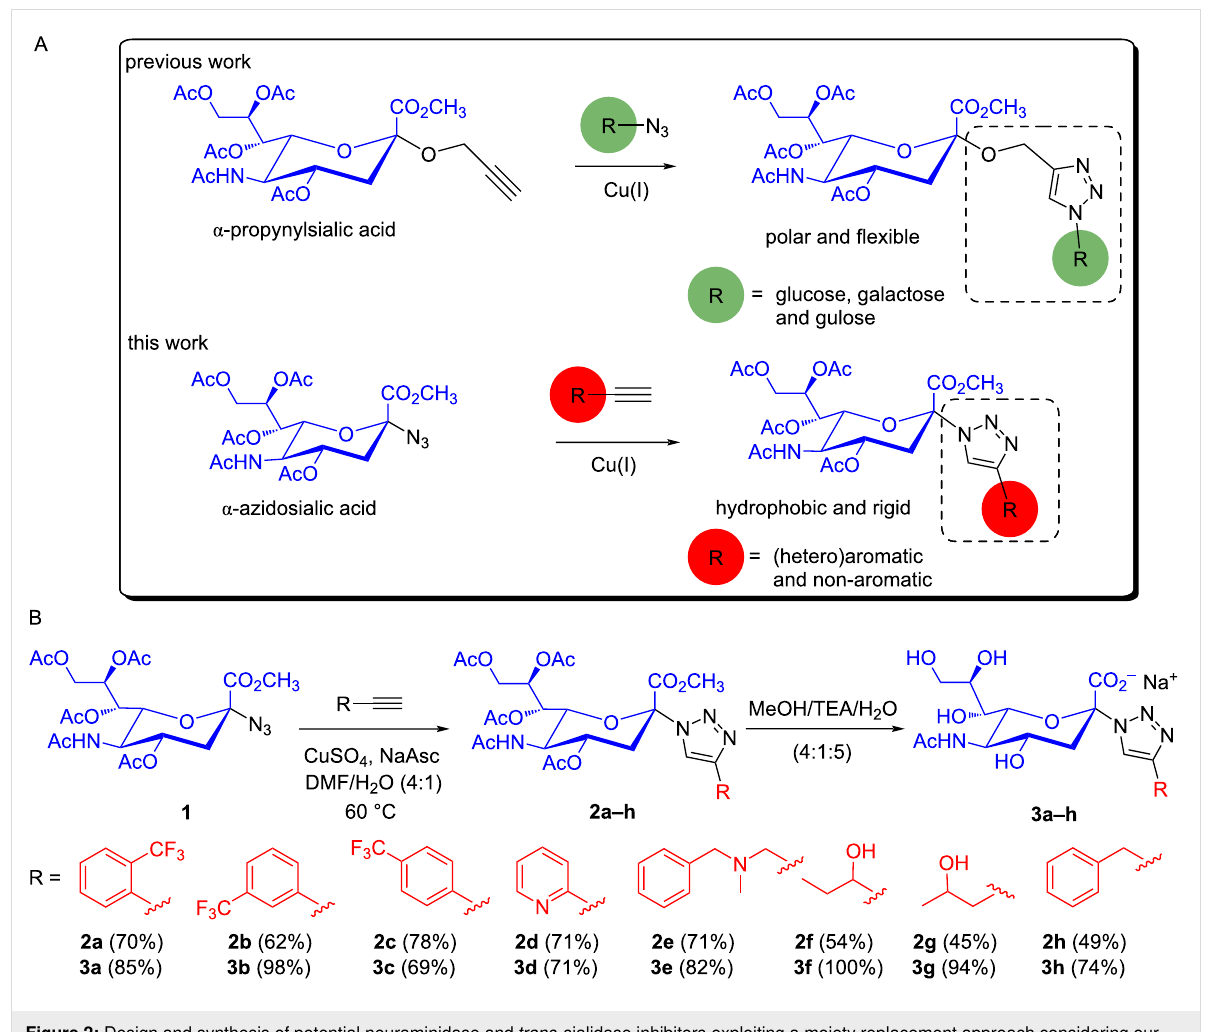
Figure 2: Design and synthesis of potential neuraminidase and trans -sialidase inhibitors exploiting a moiety replacement approach considering our previous work (A) and synthesis of 1,2,3-triazole-linked sialic acid derivatives 3a–h via copper-catalysed azide–alkyne cycloaddition (CuAAC) from the key intermediate 1 (B).